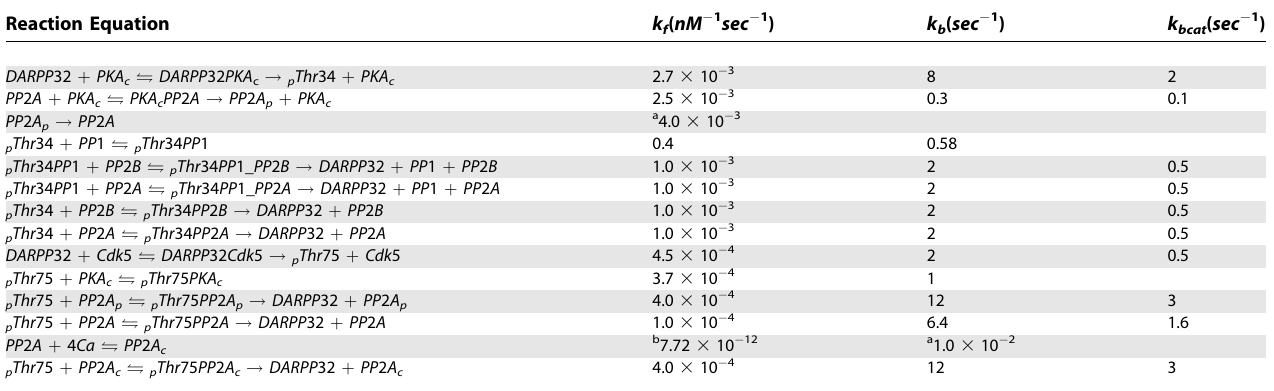
Table 3. Reactions and Rate Constants of Phosphor/Dephosphorylation of DARPP-32 Reaction Equation k f ( nM (cid:1) 1 sec (cid:1) 1 ) k b ( sec (cid:1) 1 )